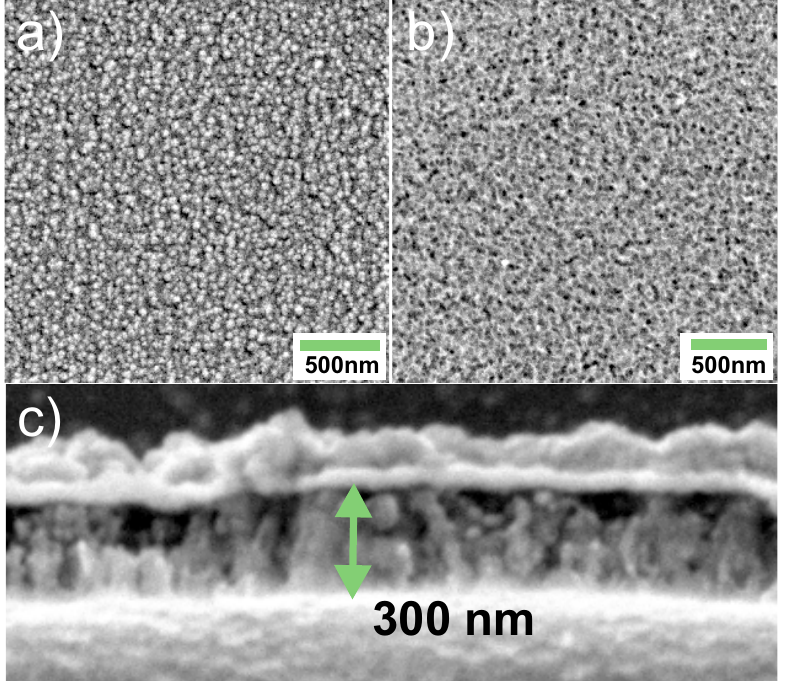
Figure 3. SEM images of ( a ) anodized titanium oxide layer and ( b ) anodized iron oxide layer. The bottom image ( c ) shows a cross-section of